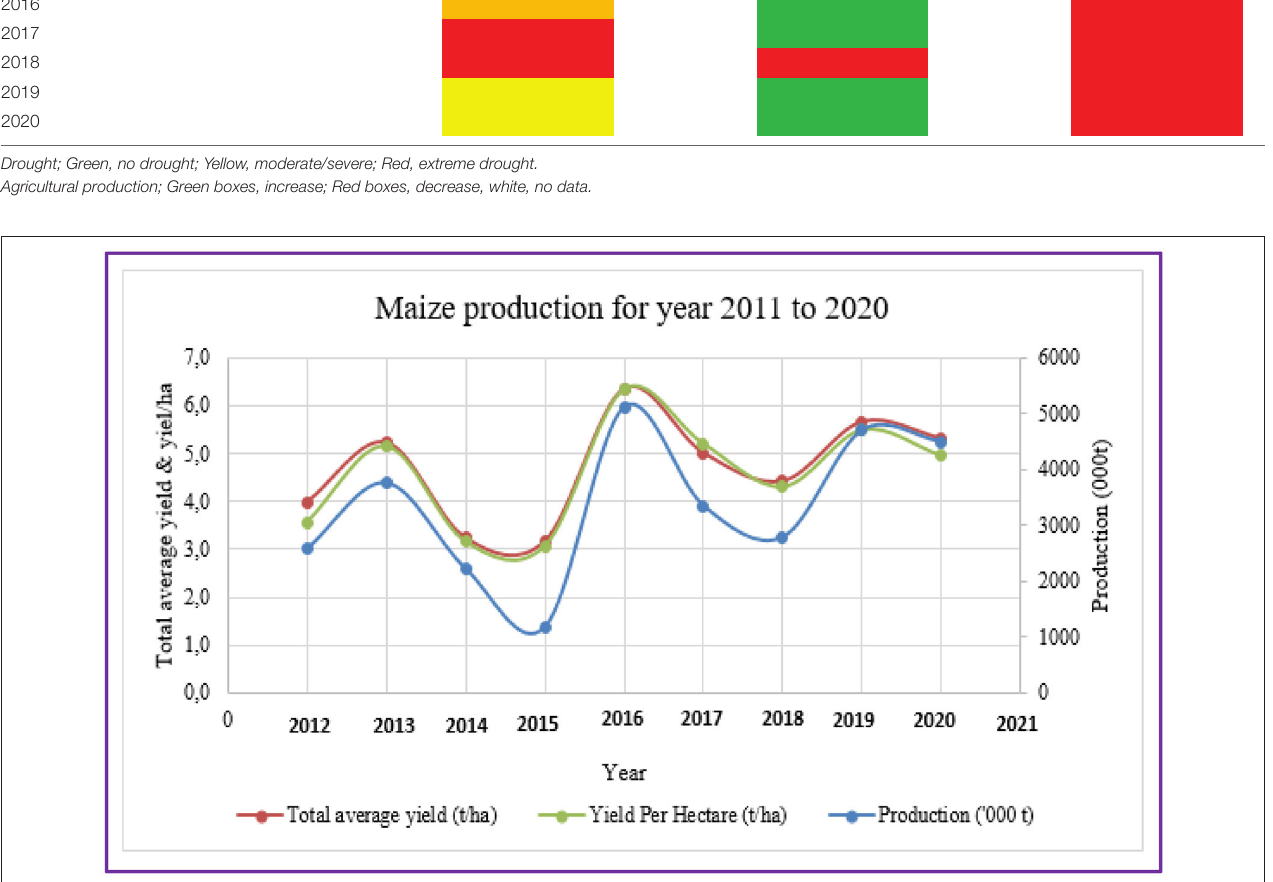
FIGURE 4 | Maize for year